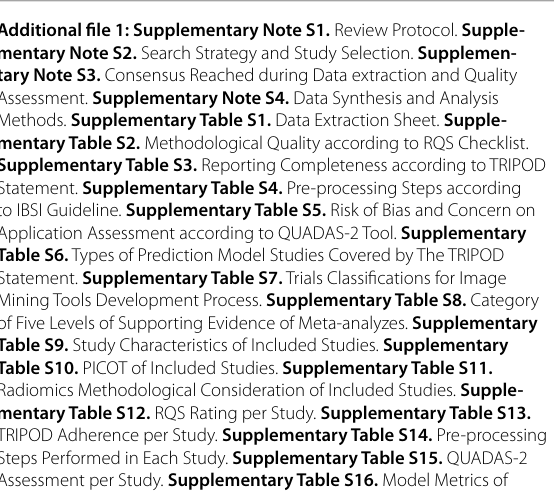
Assessment per Study. Supplementary Table S16. Model Metrics of